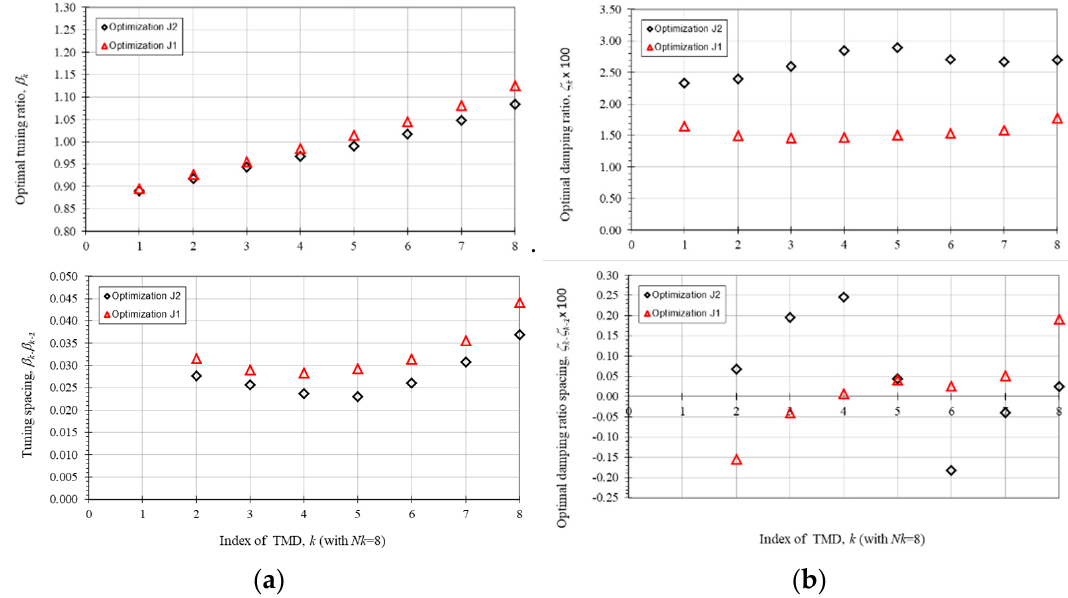
Figure 15. ( a ) Optimal tuning ratios β k and optimal tuning spacings β k − β k − 1 ; ( b ) optimal damping ratios ζ kt and damping ratios’ spacings ζ k − ζ k − 1 of the individual TMD for N k = 8, µ = 0.02, and ζ 1 = 0.02.